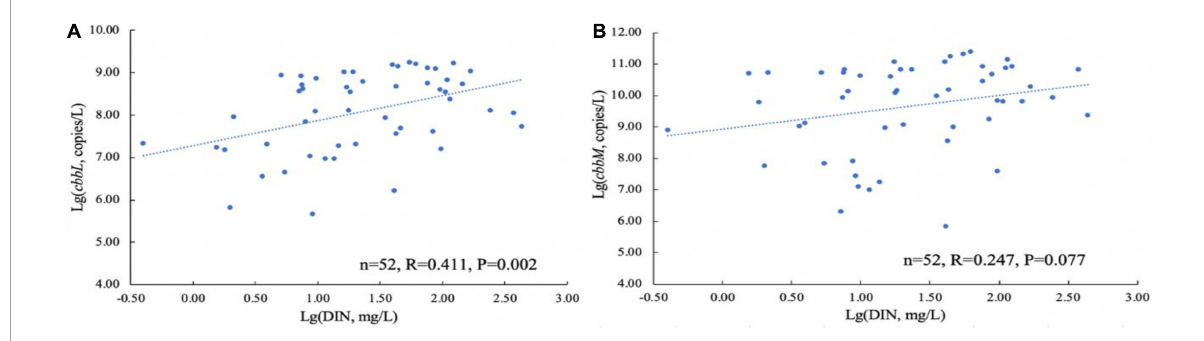
FIGURE4 Relationship between the carbon-fixing genes and DIN concentration in the Huixian karst groundwaters. (A) cbbL gene; (B) cbbM gene.